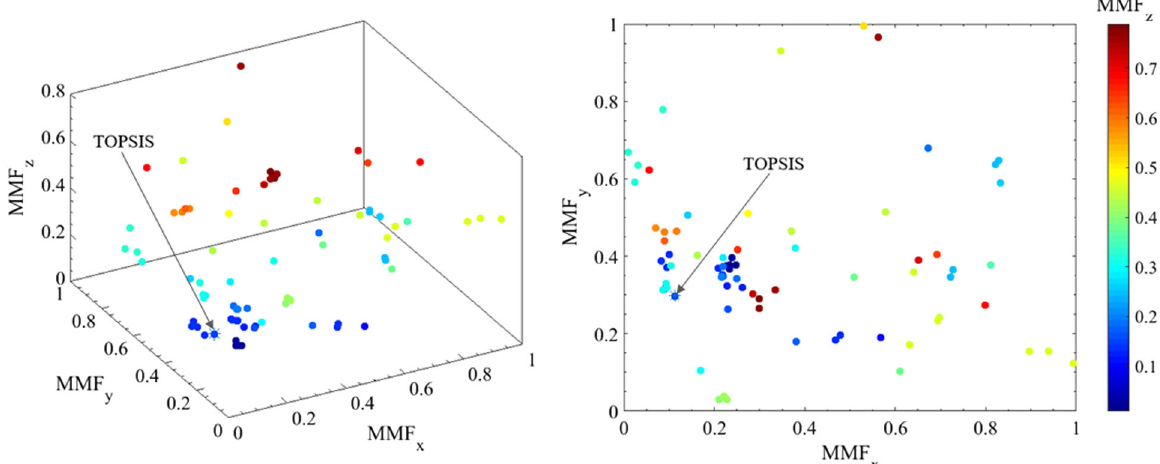
FIG. 9. Pareto optimal front of the last generations and the TOPSIS selected point. Mismatching factor along the transverse x direction versus mismatching factor along the transverse y direction (right), and (left) the longitudinal z direction as a function of x and y transverse plane mismatching factors while the transmission is more than 94%.